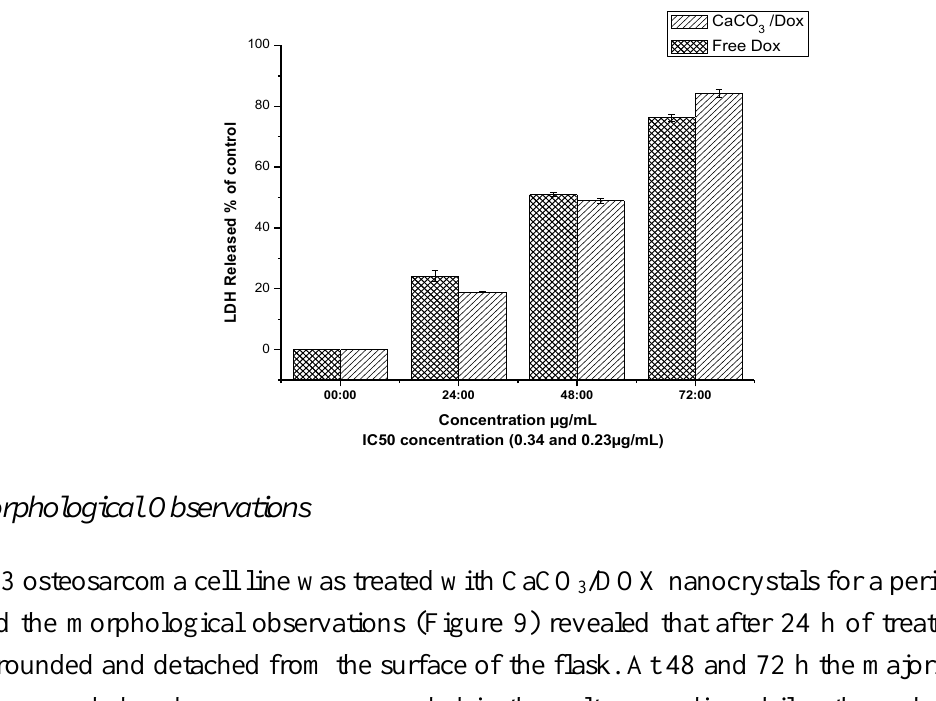
Figure 8. LDH released analysed for membrane integrity assay.